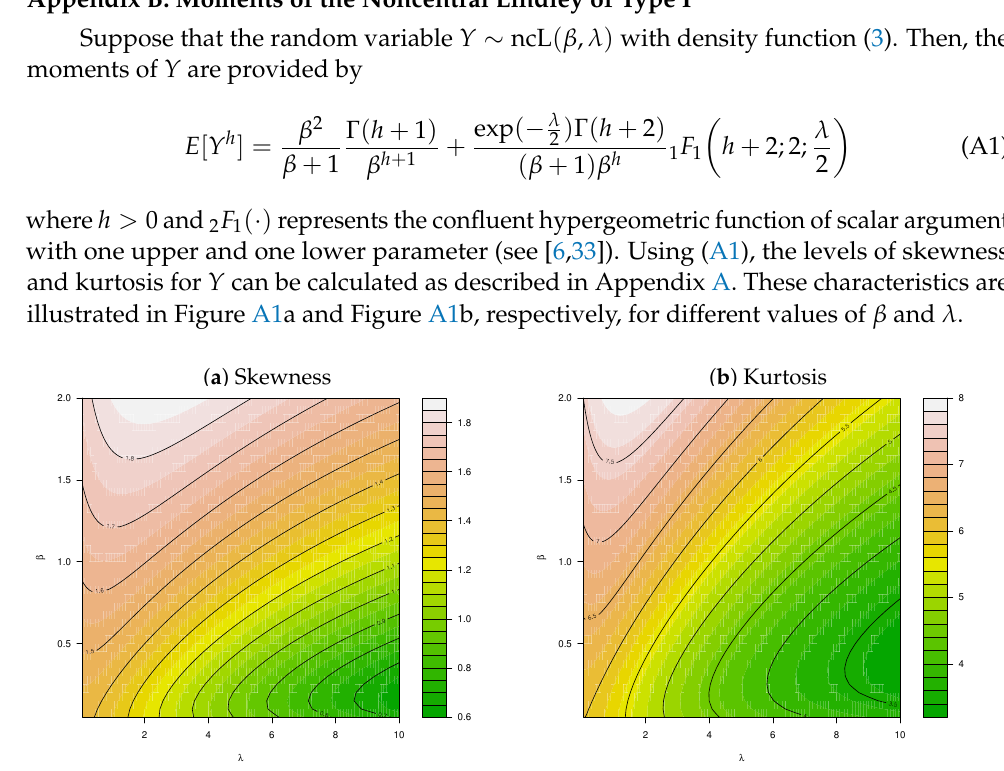
Figure A1. Skewness and kurtosis for Y ∼ ncLI( β , λ ) for different values of β and λ